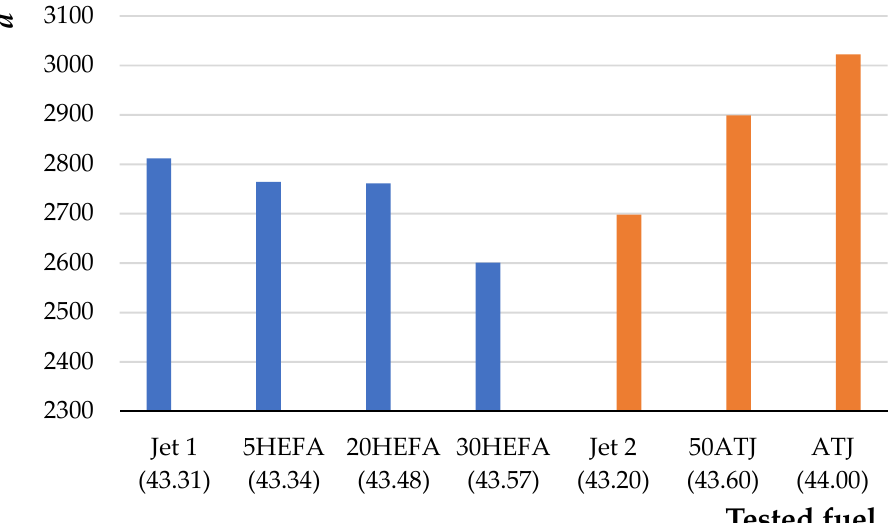
Figure 5. The influence of concentration of HEFA component in blend with Jet A-1 on the a parameter (net heat of combustion [MJ/kg] in brackets).